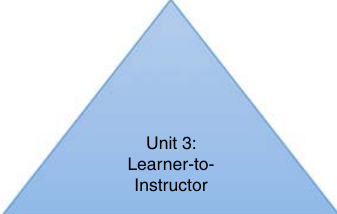
Figure 4. Learner-to-instructor